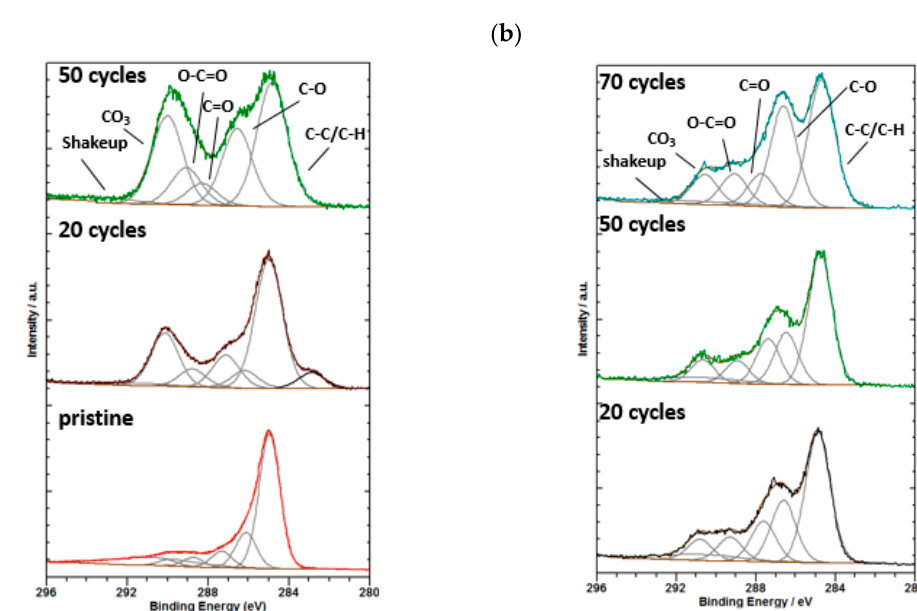
Figure 7. ( a ) C1s detail spectra of pristine and cycled electrodes without VC-containing electrolytes after 20 and 50 cycles and ( b ) Si/MC electrodes with VC-containing electrolytes after 20, 50, and 70 cycles.